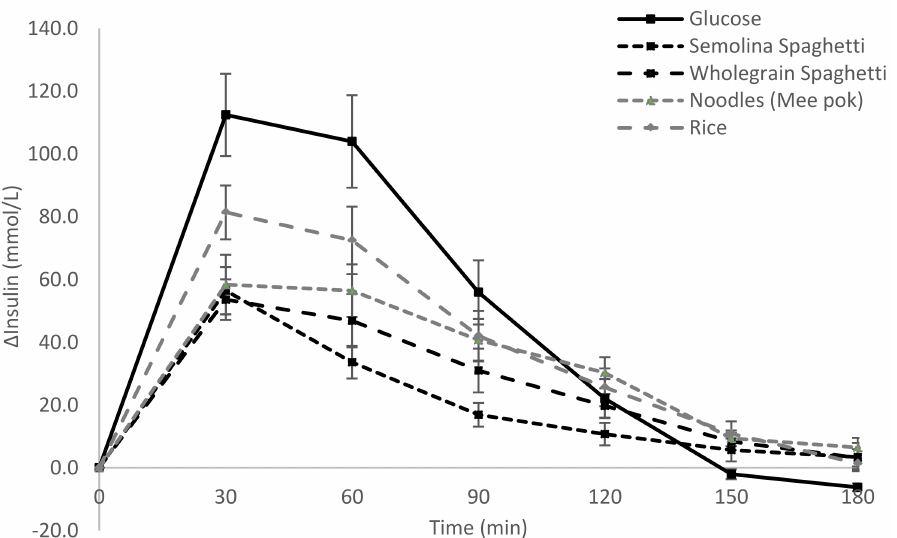
Figure 2. Postprandial change in insulin (mean ± standard